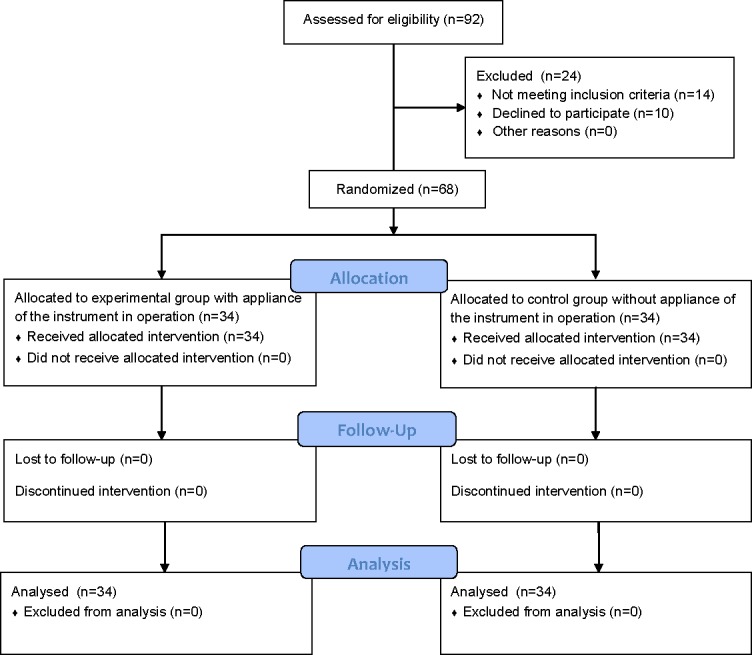
CONSORT flow diagram.Flow diagram displaying the progress of all participants throughout the trial.